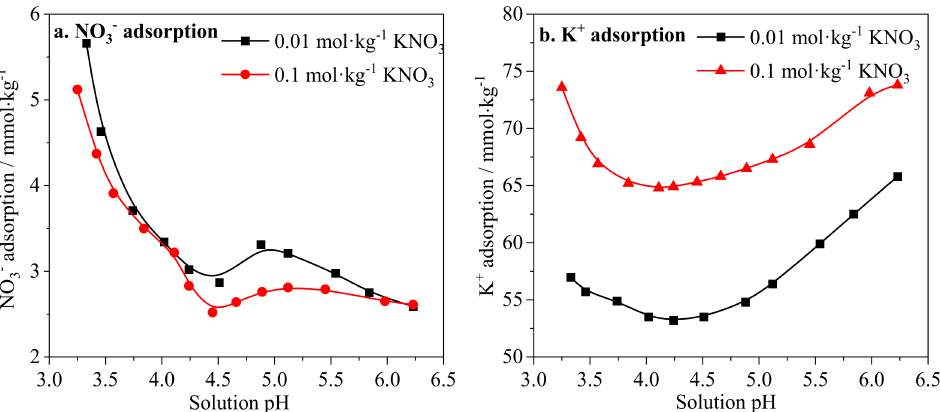
Figure 7. The adsorption curves of K + and NO 3 − on IREOs with pH change in two different concentrations of potassium nitrite solutions. ( a ) NO 3 − adsorption; ( b ) K +